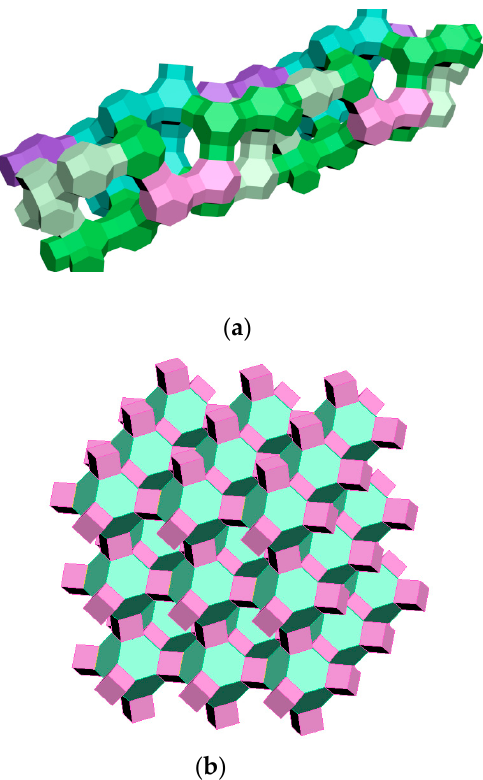
Figure 12. Three-dimensional structure of zeolites: ( a ) FAU type zeolite (X and Y); ( b ) A type zeolite (LTA) [compiled by the authors].